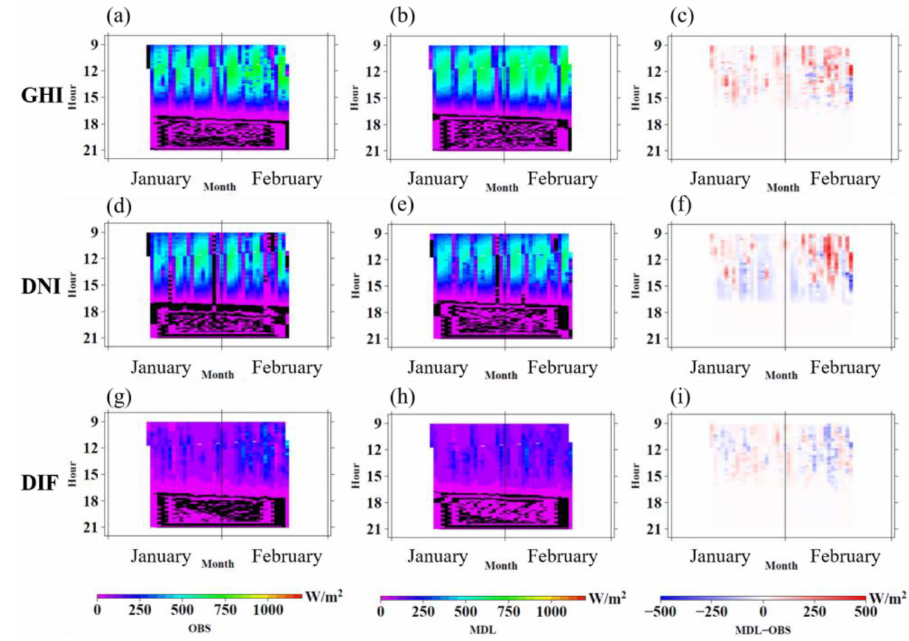
Figure 4. Same as Figure 3, but for the Exp-Winter of